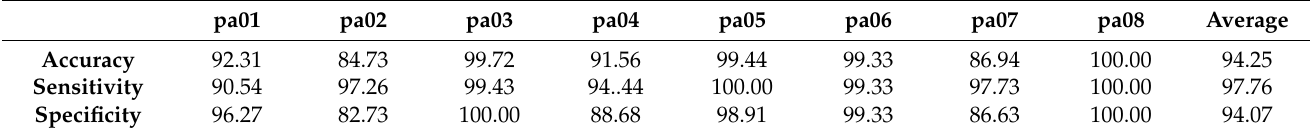
Table 6. The performance of 1 s SWT segments under proposed model using ZJU4H dataset.